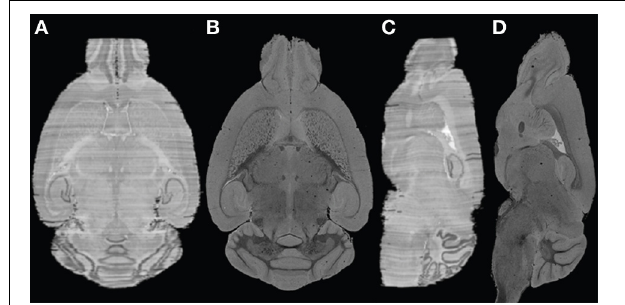
FIGURE 1 | Example of histological volume reconstructed for the mouse brain. (A) and (C) axial and coronal views of the constructed histological volume; (B) and (D) the corresponding MR